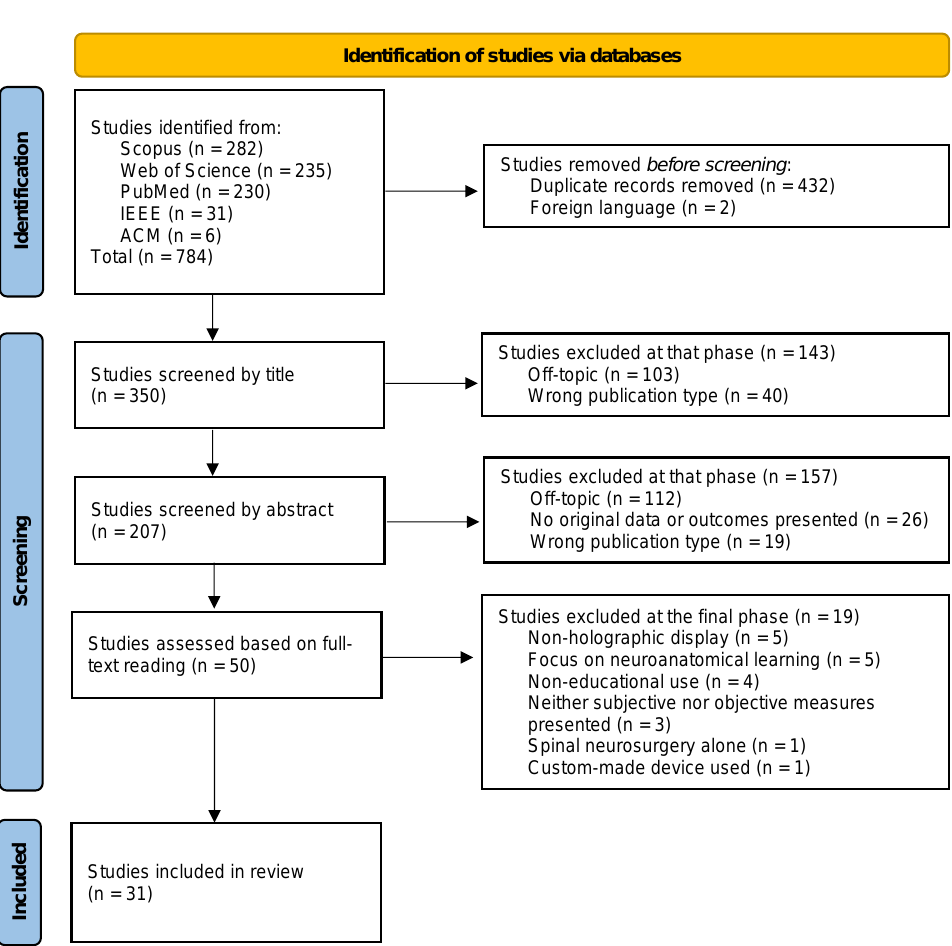
Figure 2. Study selection (PRISMA) flow chart. Summary of the selection process applied in the present review, divided into identification, screening, and inclusion